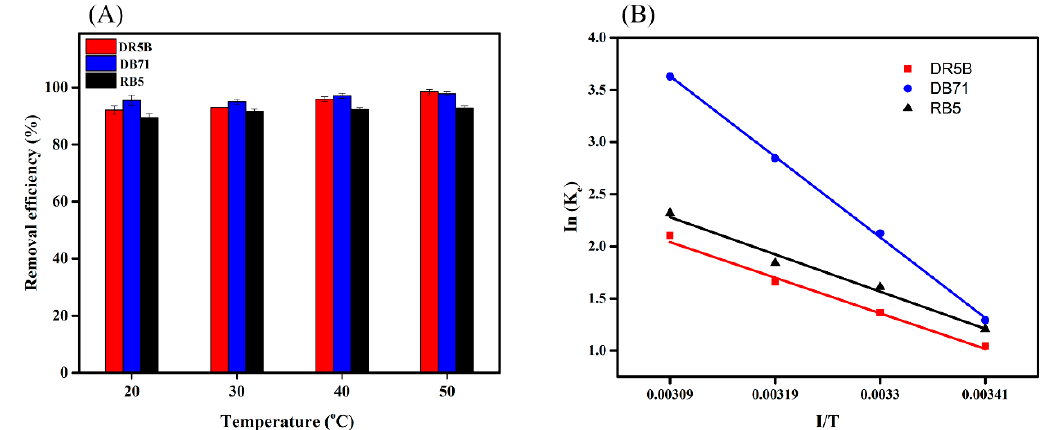
Figure 7. Effect of temperature on dye removal ( A ) and thermodynamic study ( B ).